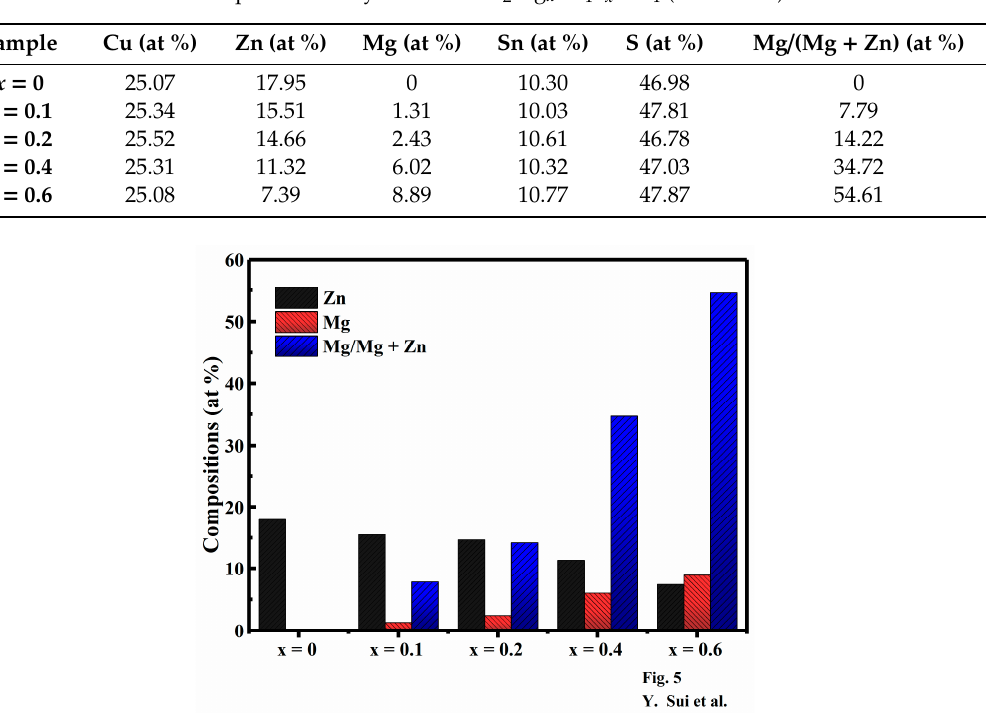
Figure 5. Energy dispersive X-ray spectroscopy (EDS) composition analyses of Cu 2 Mg x Zn 1 − x SnS 4 (0 ≤ x ≤ 0.6) thin films. Table 2. EDS composition analyses of the Cu 2 Mg x Zn 1- x SnS 4 (0 ≤ x ≤ 0.6) thin films.